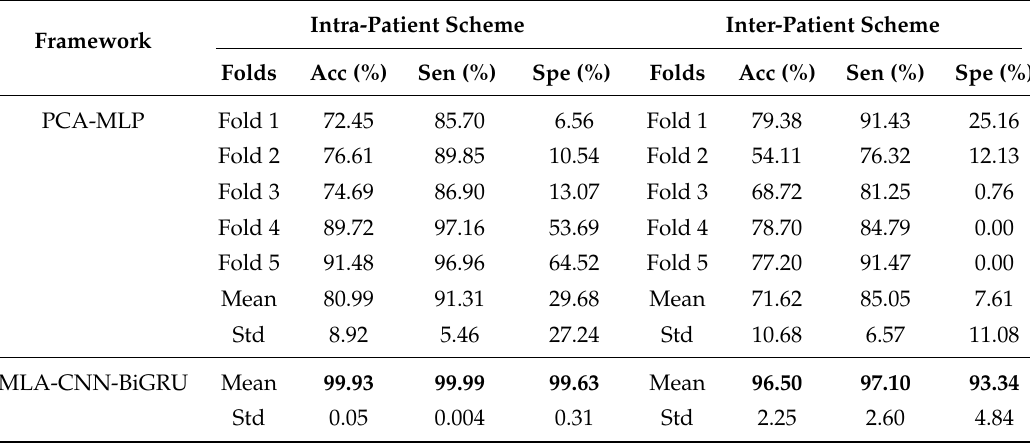
Table 3. Comparative experiments of MI detection by five-fold